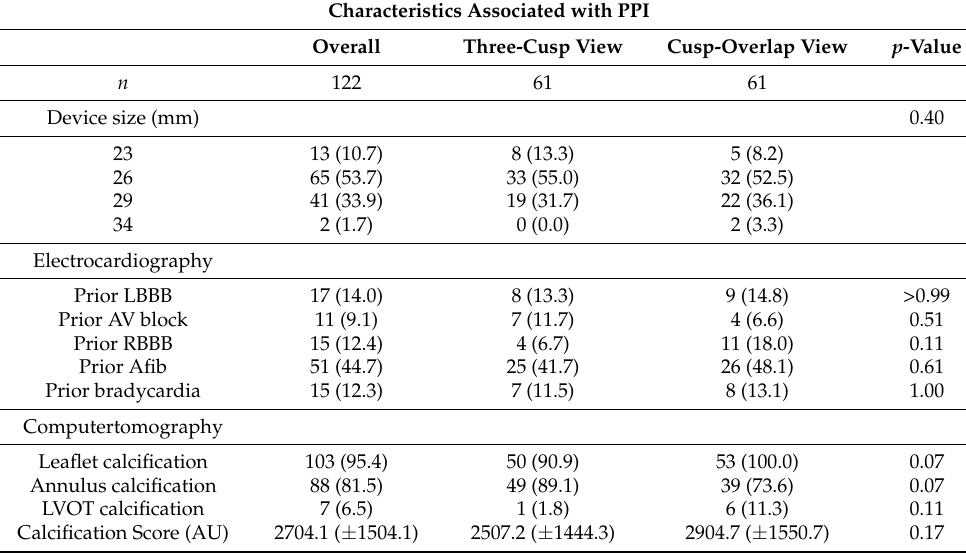
Table 2. Device sizes as well as electrocardiographic and computertomographic characteristics of patients.